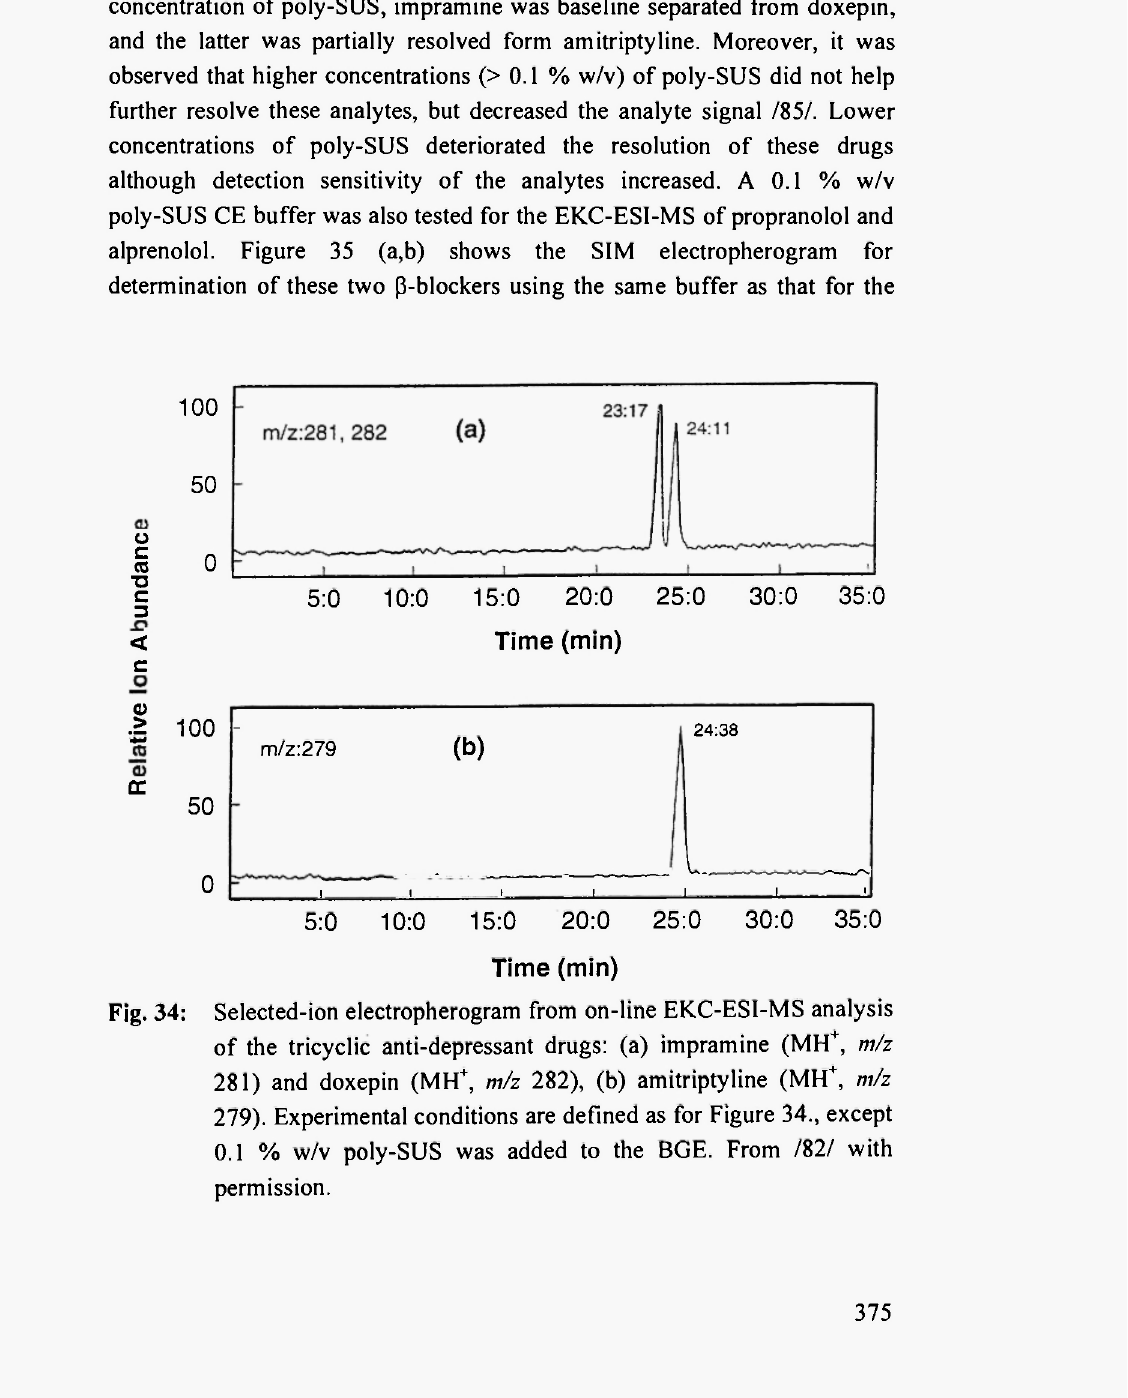
Fig. 34: Selected-ion electropherogram from on-line EKC-ESI-MS analysis of the tricyclic anti-depressant drugs: (a) impramine (MH + , m/z 281) and doxepin (MH + , m/z 282), (b) amitriptyline (MH + , m/z 279). Experimental conditions are defined as for Figure 34., except 0.1 % w/v poly-SUS was added to the BGE. From /82/ with